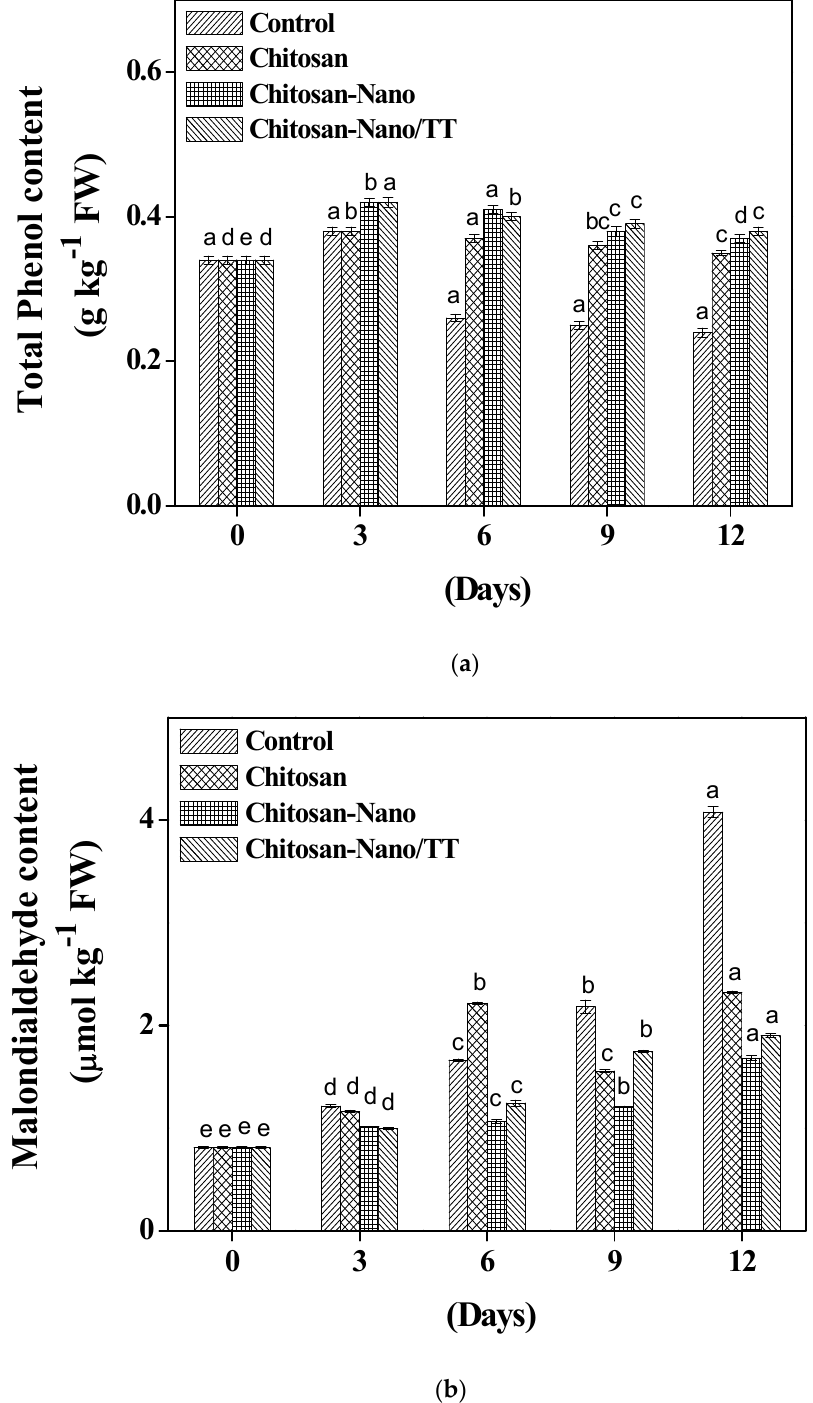
Figure 3. Effect of total phenol ( a ) and malondialdehyde ( b ) contents on mushrooms during storage; * Different small letters a;b;c;d mean significant differences between treatments at p ≤ 0.